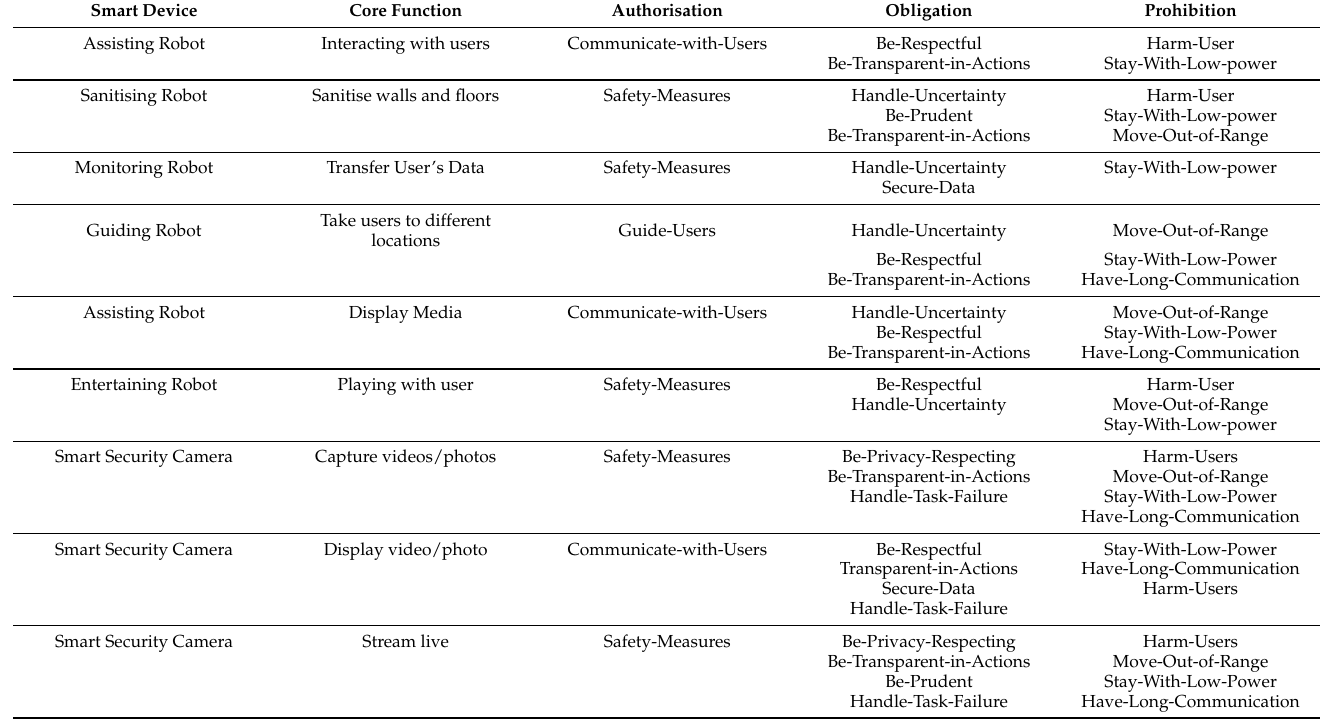
Table 8. Socio-ethical policies and core functions mapping—early learning centre.